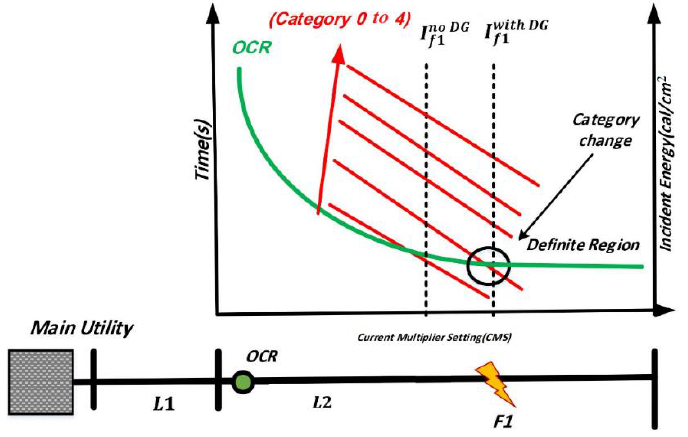
Figure 1. The OCR characteristics and AFIE categories in DN with and without DG.